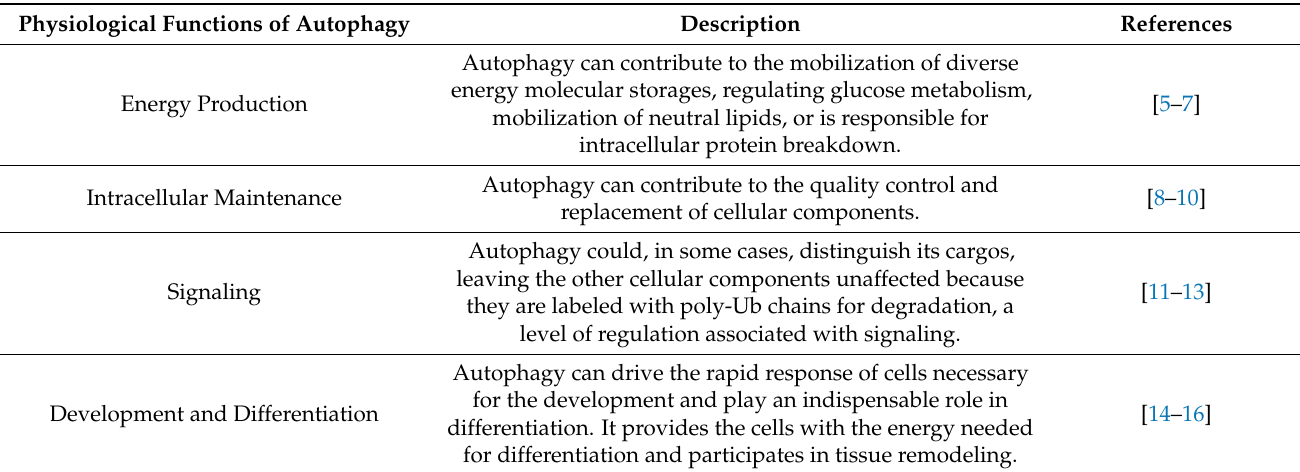
Table 1. Autophagy physiological functions, main characteristics. Physiological Functions of Autophagy